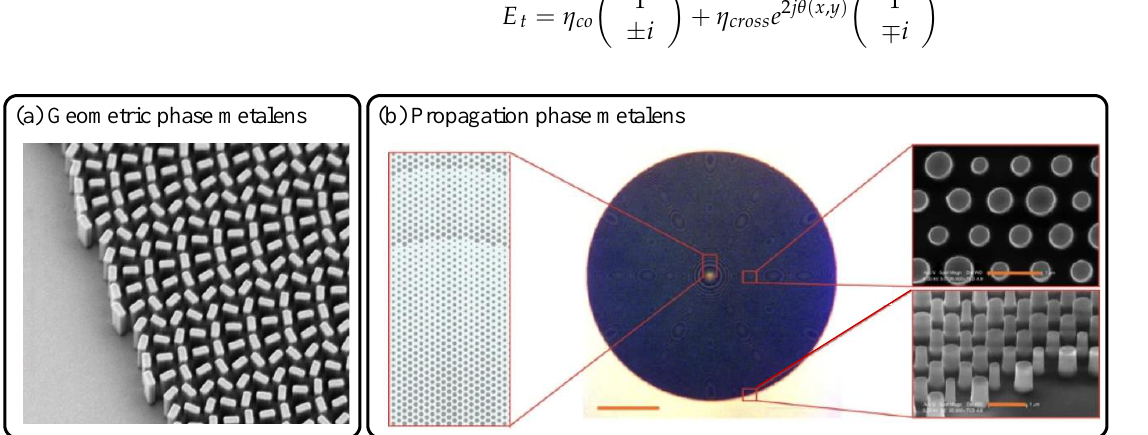
Figure 1. ( a ) Scanning electron microscope image of the geometric-phase-based TiO 2 nanofin metalens reported in 2016 [9]. ( b ) Optical micrograph (scale bar: 100 μm) and scanning electron microscope images of the propagation-phase-based a-Si nanopost metalens reported in 2015 [10]. The scalebars in inset electron beam images of ( b ) refer to 1 μm. ( a ) Reprinted with permission from [9]. Copyright 2016 The American Association for the Advancement of Science. ( b ) Reprinted with permission from [10]. Copyright 2015 Springer Nature.